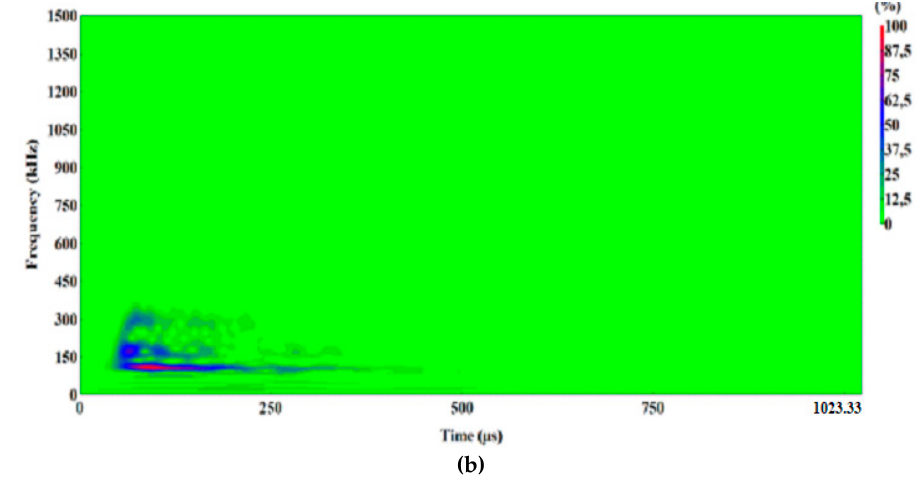
Figure 10. Waveform frequency domain (Real) ( a ) and waveform continuous wavelet (Morlet) ( b ) charts for the individual classes of AE signals (class 1).